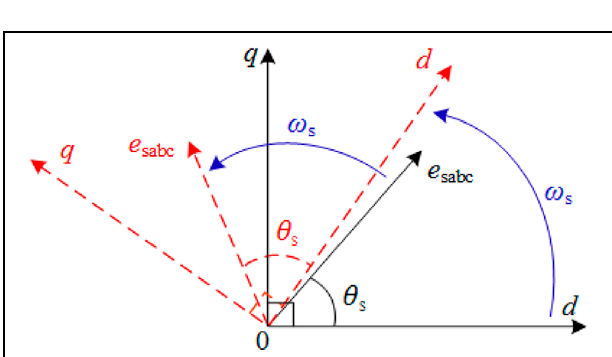
FIGURE 4 | Schematic diagram of open-loop phase detection.